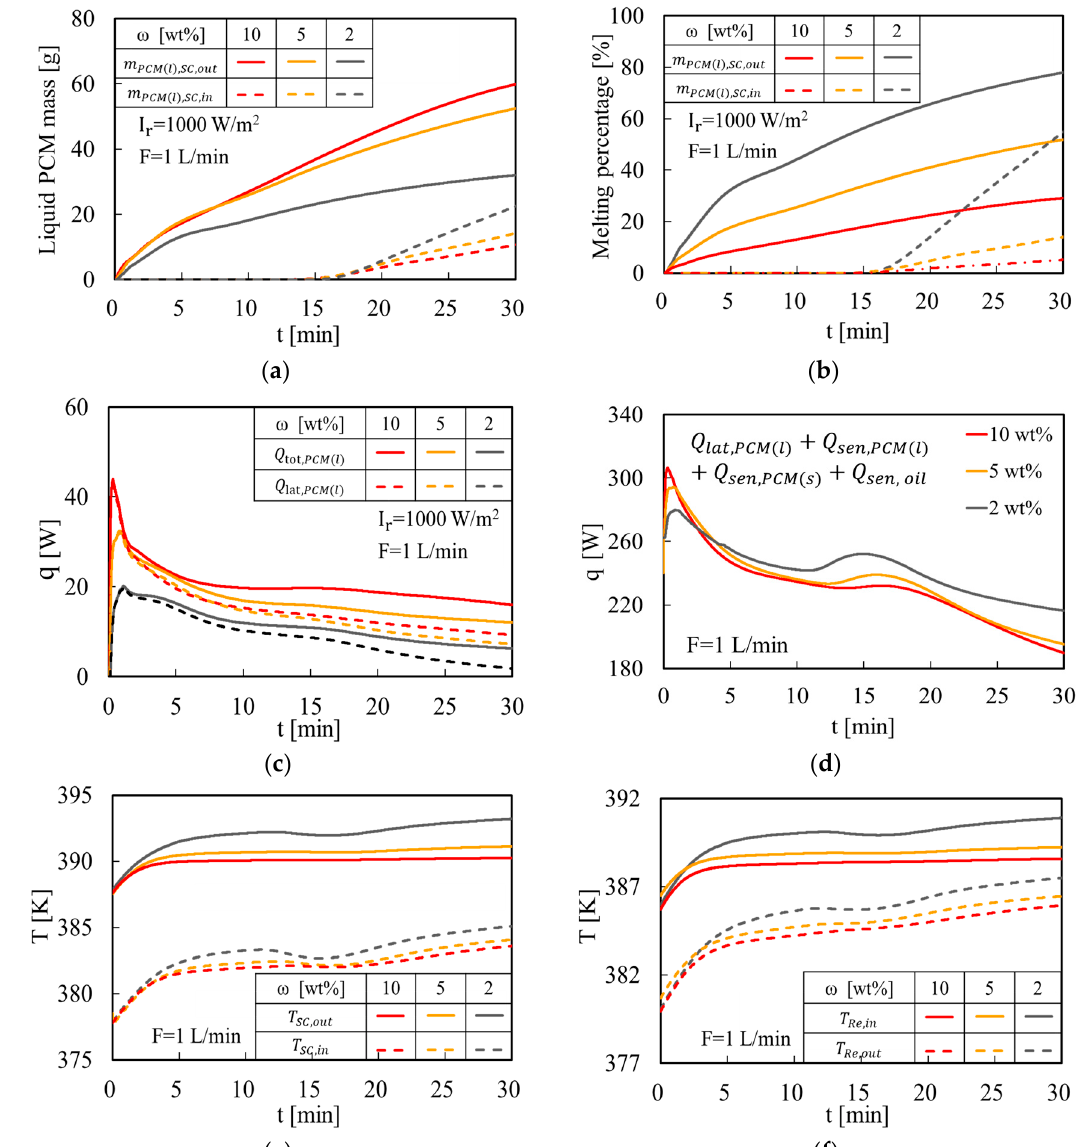
Figure 7. Several melting performances at different PCM weight fractions: ( a ) mass of liquid PCM over time; ( b ) melting percentage of liquid PCM over time; ( c ) recovered heat from liquid PCM; ( d ) effects of weight fraction on total recovered heat of PCM fluid, including sensible heat of silicone oil, solid PCM, and liquid PCM as well as latent heat; ( e ) temperature of PCM fluid at the SC inlet/outlet after melting over time; ( f ) temperature of PCM fluid at the Re inlet/outlet after melting over time.